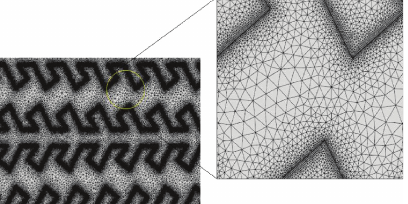
Figure 7: Schematic of mesh generated after extra refinement is made at the edge surface of the fishbone shaped electrostatic comb driver fingers.